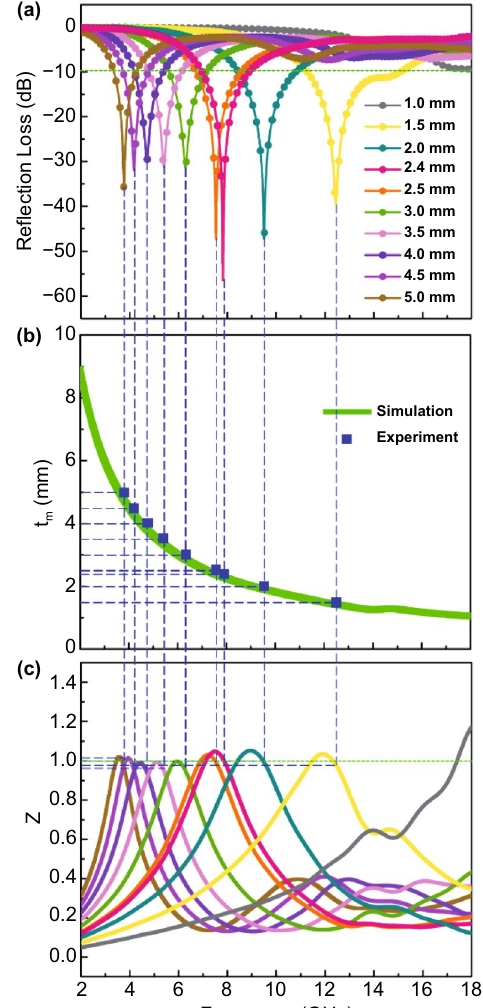
Fig. 8 a RL-frequency curves, b relationship between simulation thickness and peak frequency, and c relationship between Z in / Z 0 and electromagnetic wave frequency of